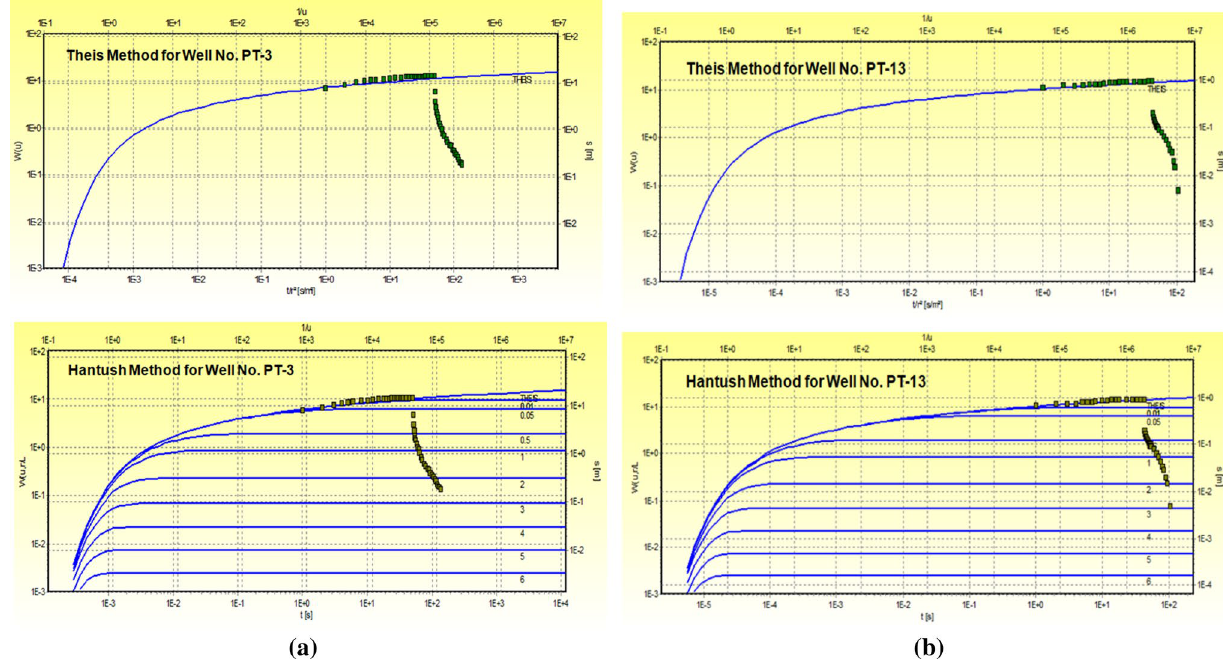
Fig. 3 Interpreted time-drawdown/recovery plot by Theis and Hantush methods for test in pediplain with moderate weathering (PPM) and pediplain with shallow weathering (PPS) geomorphologic